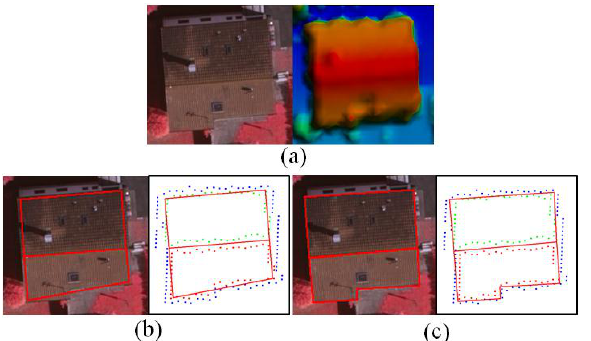
Figure 4. Sequential rooftop modelling process from: (a) airborne image (left) and LiDAR data (right); (b) L-Model (initial LiDAR-driven model); and (c) improved rooftop model.